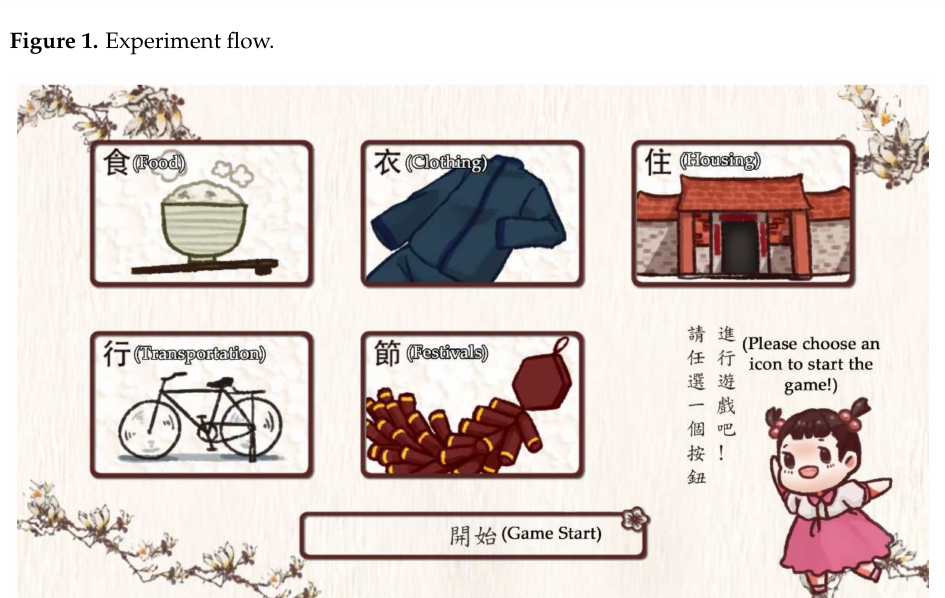
Figure 2. Cognitive Game based on Nostalgia